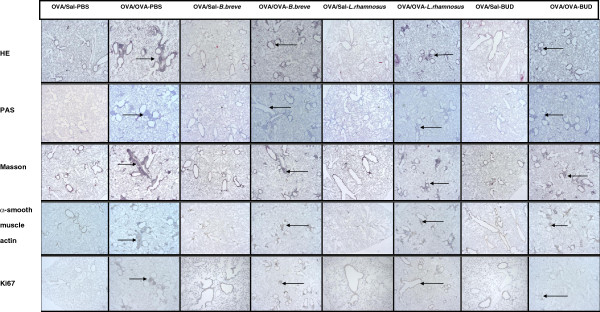
Beneficial bacteria and budesonide suppress airway remodelling features in chronic asthmatic mice. Representative photomicrographs for 5 mice/group of hitstological and immunohistochemical staining for inflammation (hematoxylin-eosin, HE); goblet cells (periodic acid Schiff, PAS); connective tissue (Masson trichrome, Masson); Anti-α-smooth muscle actin (α-smooth muscle) and proliferating cells (Anti-Ki67) in lung tissue of sensitised only (OVA/Sal) and sensitised and challenged (OVA/OVA) mice treated with PBS, B. breve, L. rhamnosus or budesonide (BUD). Original magnification, 40X, except for anti-Ki67 100X.